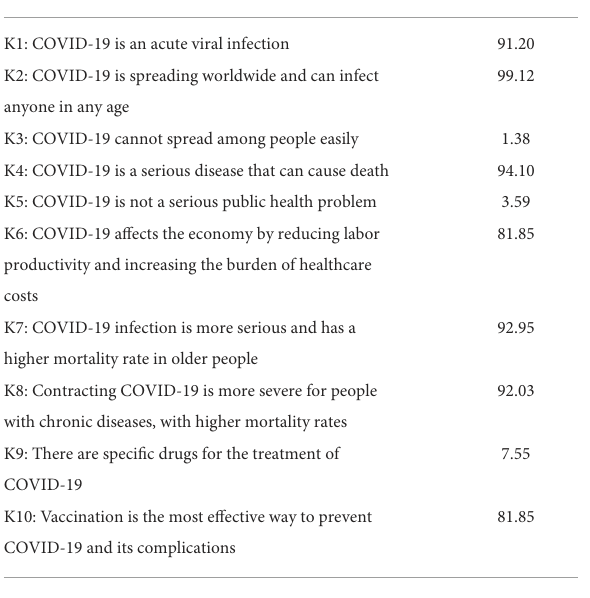
TABLE 1 Cognition of COVID-19.